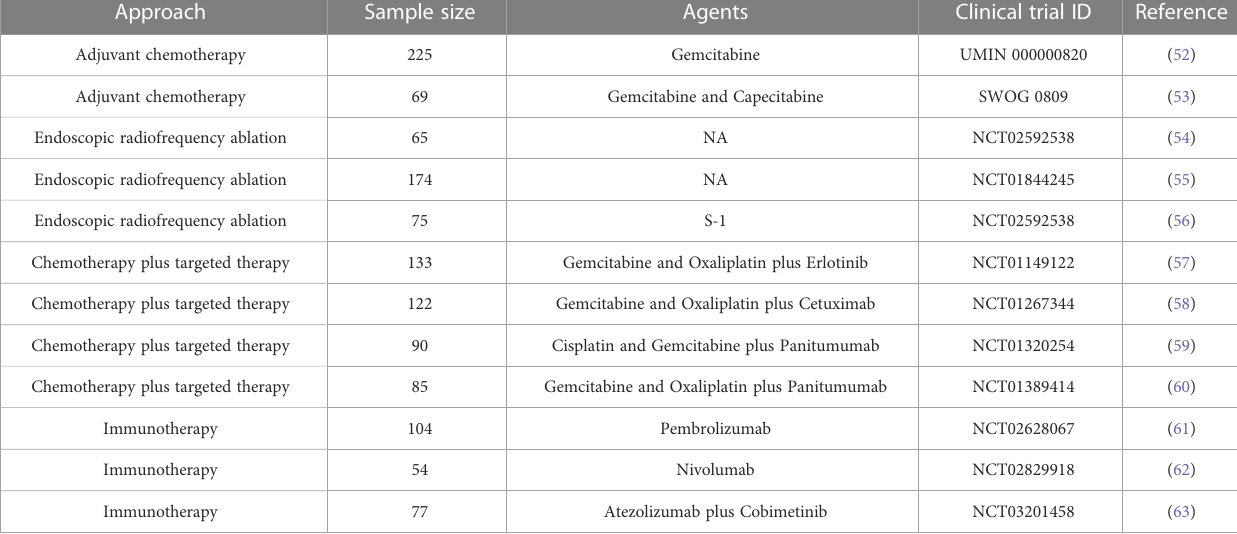
TABLE 2 Robust clinical trials of extrahepatic